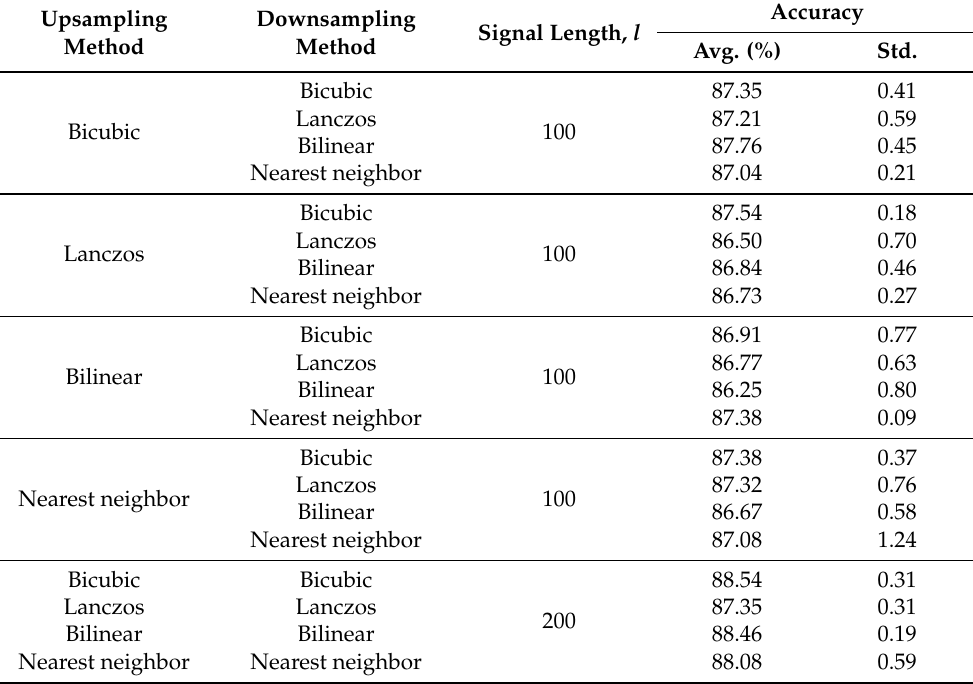
Table 3. Interpolation methods in different upsampling and downsampling